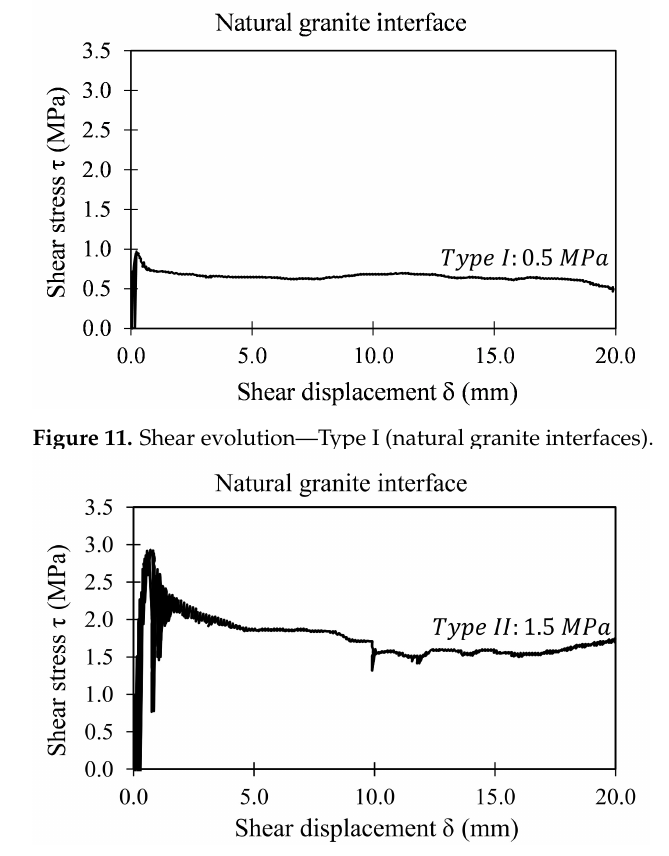
Figure 12. Shear evolution—Type II (natural granite interfaces).